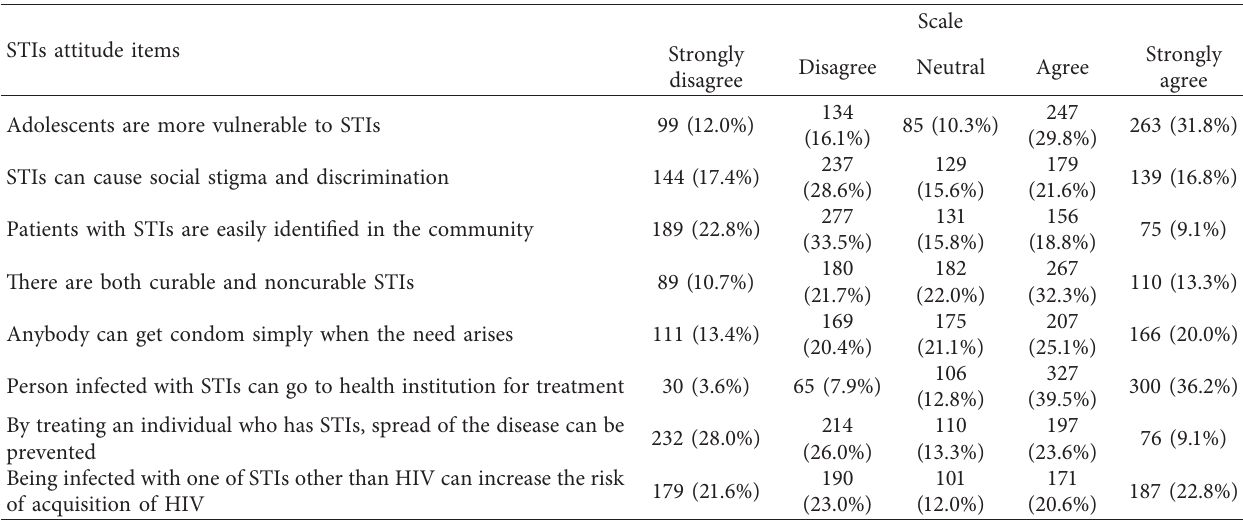
Table 3: Attitudes of preparatory school students towards STIs, West Gojjam zone, Northwest Ethiopia, 2018. STIs attitude